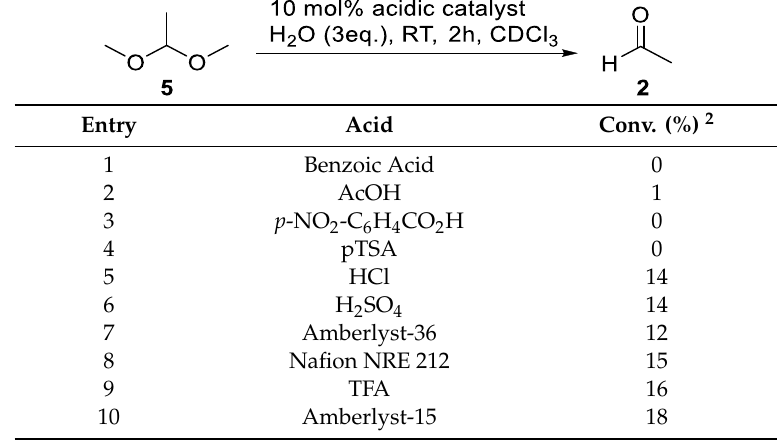
Table 1. Results of the acid-catalysed deprotection of acetaldehyde dimethyl acetal 1 .